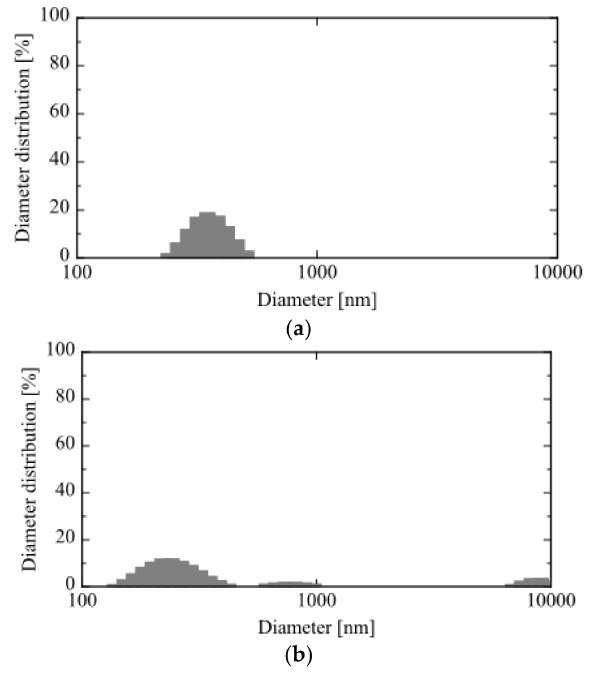
Figure 5. SEM image ( a ) and size distribution ( b ) of the industrial silica particle suspension.